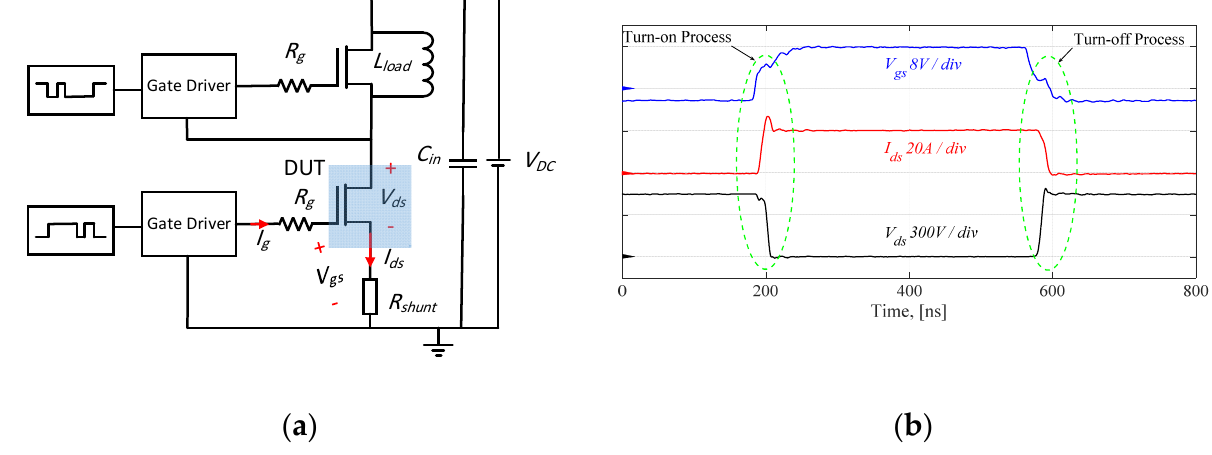
Figure 3. Double-pulse test circuit: ( a ) schematic of the DPT and ( b ) typical waveforms. Figure 3b depicts the typical inductive double-pulse switching waveforms, the